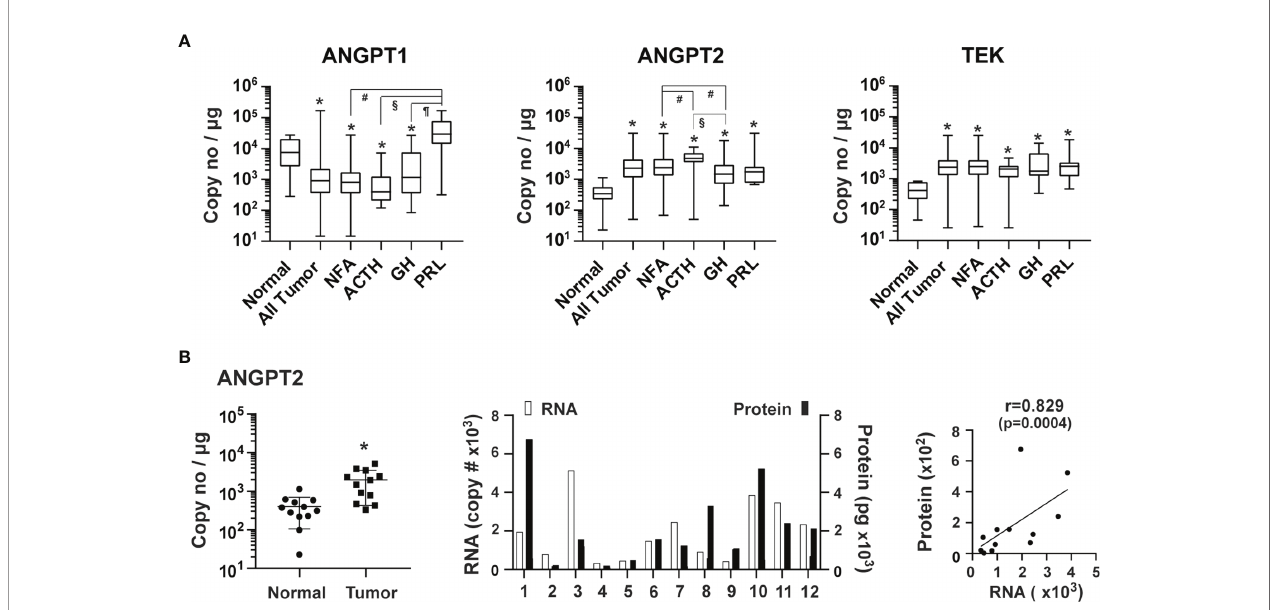
FIGURE 4 | Expression of angiopoietins and their receptor, TEK, in human pituitary tumors. (A) RNA expression of ANGPT1, ANGPT2 and TEK was quanti fi ed by TaqMan ® probe-based qPCR. Normal pituitary tissue, n = 12; NFA, n = 140; ACTH, n = 16; GH, n = 38; PRL, n = 13. *p < 0.05 vs normal pituitary tissue; #p < 0.05 vs NFA; §p < 0.05 vs ACTH-secreting tumors; ¶p < 0.05 vs GH-secreting tumors. (B) Correlation of ANGPT2 RNA in tumor tissue and angiopoietin 2 released by the corresponding tumors. A total of 12 pituitary tumors, including 11 NFA and 1 GH-secreting tumors were assessed. Left panel , RNA levels of endothelial markers in pituitary tumors and normal pituitary tissue. *p < 0.05 vs normal pituitary tissue. Middle panel , RNA and protein levels of individual pituitary tumors. RNA levels (open bars) are indicated on the left y-axis as copies of transcript/ m g total RNA. Protein levels (solid bars) are indicated on the right y-axis as pg/mg of tumor tissue. Right panel , correlation between RNA levels determined by qPCR and protein levels determined by